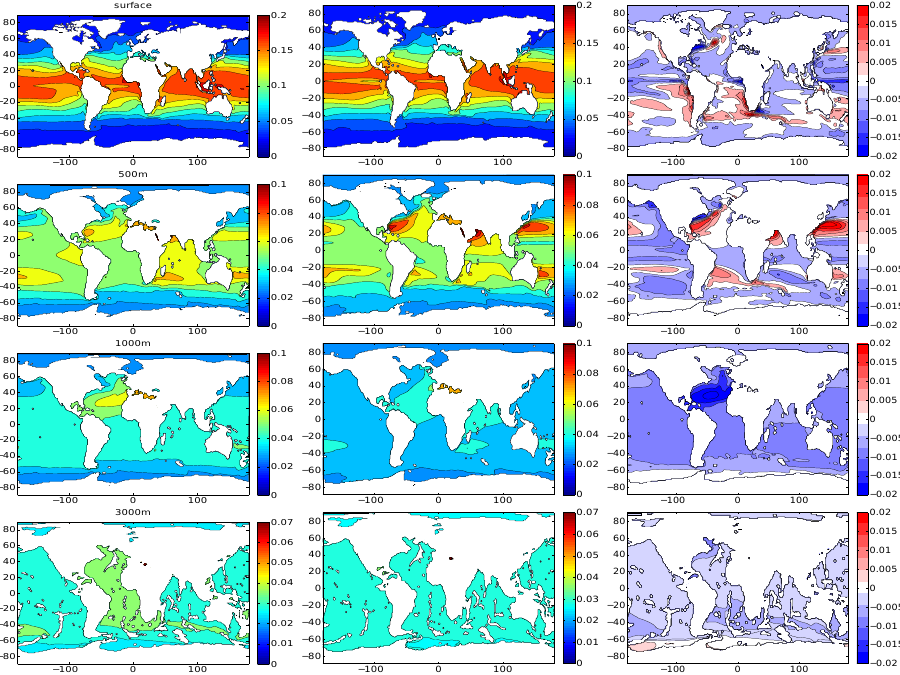
Fig. 4. Effective remineralization rate at the surface, 500, 1000 and 3000m for α = 0 . 1d − 1 (the low remineralization case). The left column is for the GISSER model, the middle column for GISSEH and the right column is the difference GISSEH − GISSER. row panels) the differences are larger, up to 50 %, for most